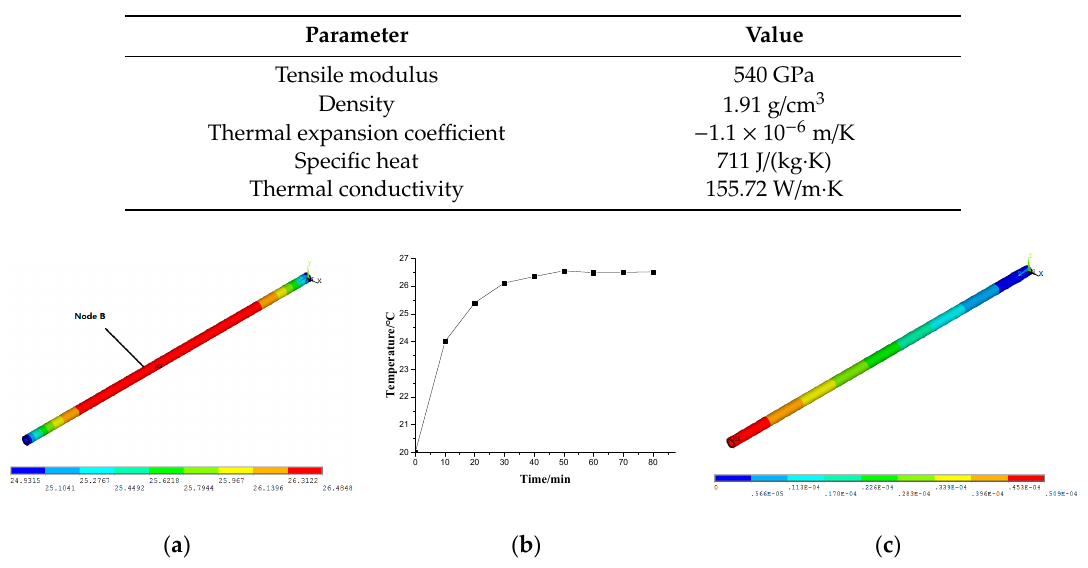
Table 4. Parameters of M55J.